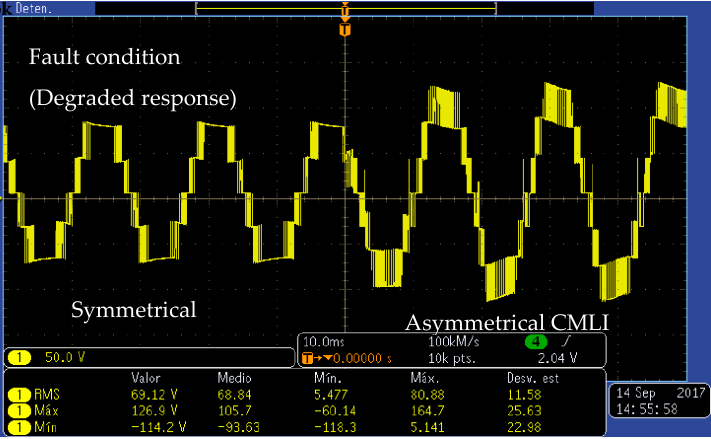
Figure 16. Oscillogram of the output voltage waveform behavior during fault condition: degraded response change to reconfiguration.